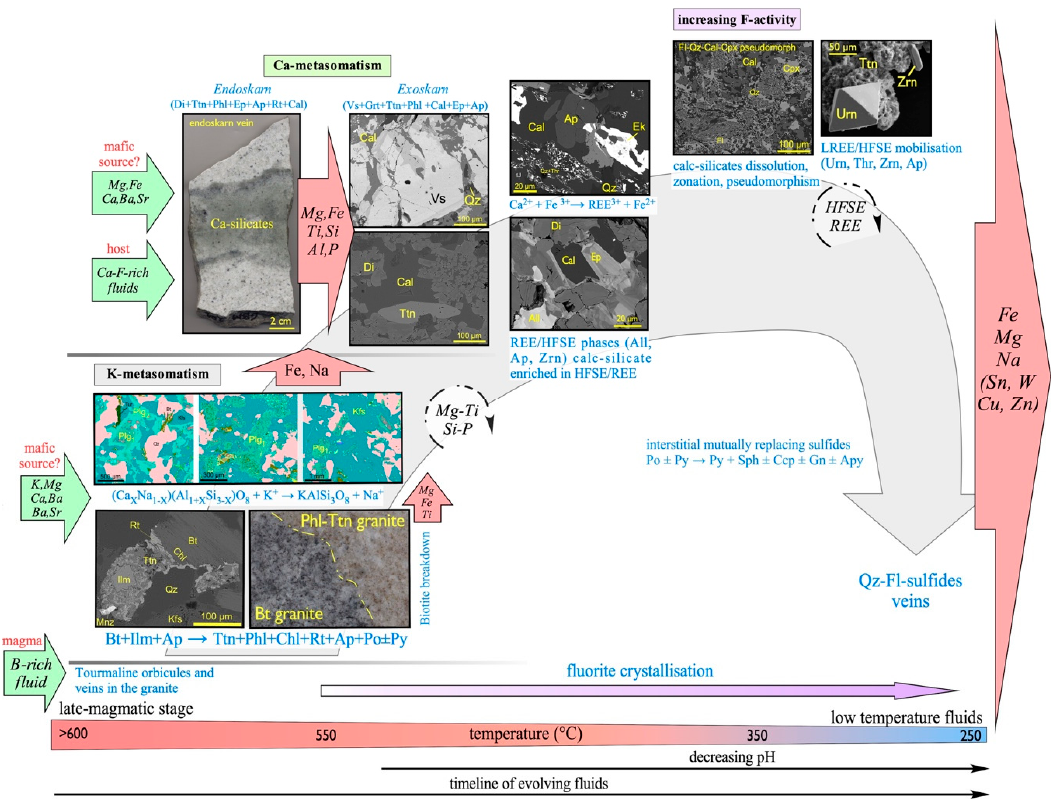
Figure 14. Schematic model for the progressive element mobilities reconstructed for the Campiglia metasomatic system, showing the main mechanism responsible for the selective mobilization of elements, and indicating the possible litho-geochemical vectors for the metasomatic processes. For mineral abbreviations [20], see Table 1.